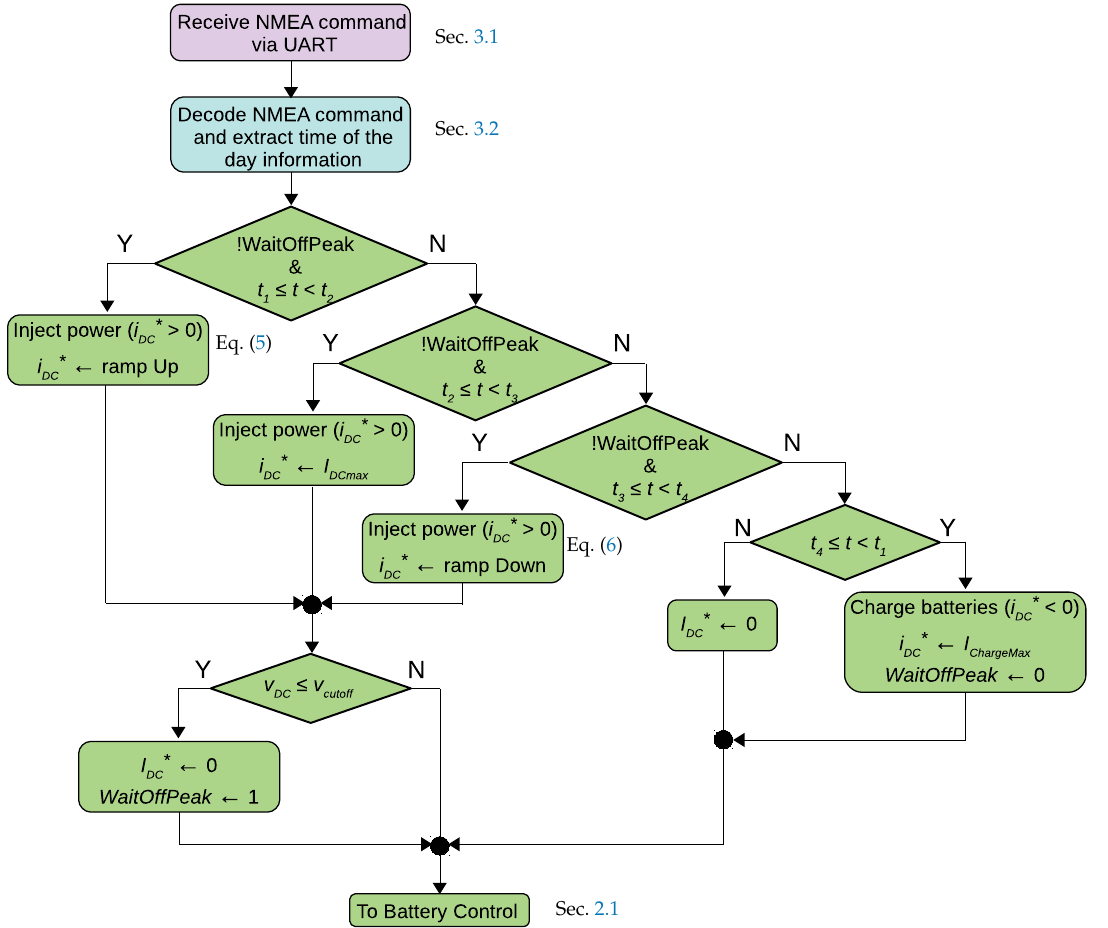
Figure 7. Algorithm to establish the reference